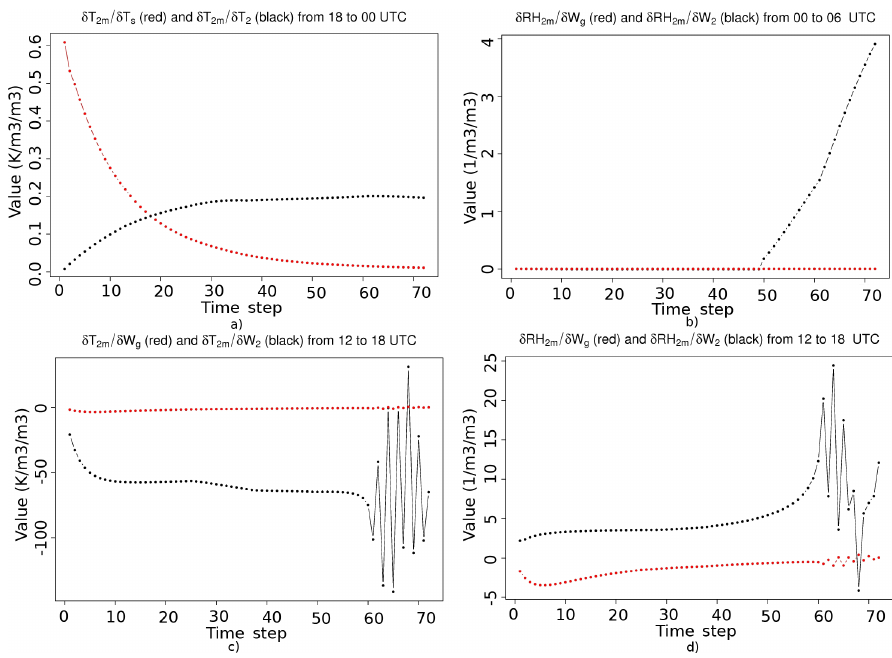
Figure 5. Evolution of the Jacobian value during a 6h offline SURFEX run for 2 July 2010 at location A (output plotted every time step). The perturbation size for the initial perturbed states is 10 − 4 . In the upper left corner δT 2m /δT s (red) and δT 2m /δT 2 (black) are shown from 18:00 to 00:00UTC, in the upper right corner δ RH 2m /δW g (red) and δ RH 2m /δW 2 (black) from 00:00 to 06:00UTC, in the lower left corner δT 2m /δW g (red) and δT 2m /δW 2 (black) from 12:00 to 18:00UTC, and in the lower right corner δ RH 2m /δW g (red) and δ RH 2m /δW 2 (black) from 12:00 to